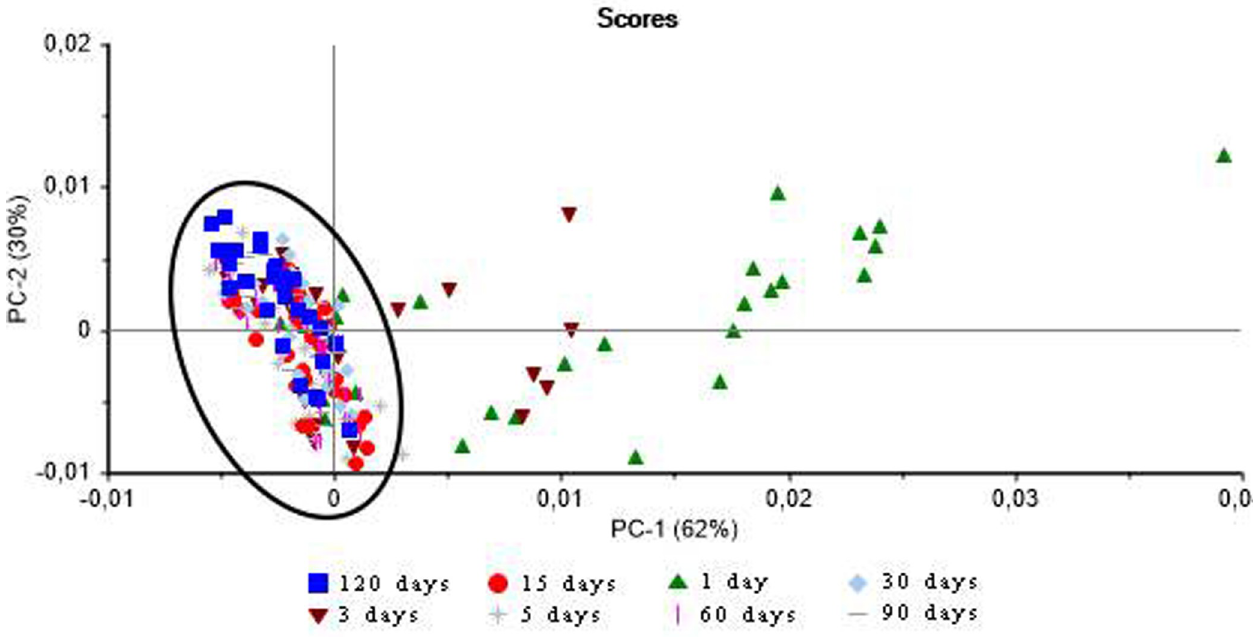
Fig 1. NIR spectra of the shells after different drying periods. Plot of the principal component scores showing variation in the spectra obtained from the shells of the three Biomphalaria species after different periods of drying. The data points circled by the ellipse represent the groups with similar results.